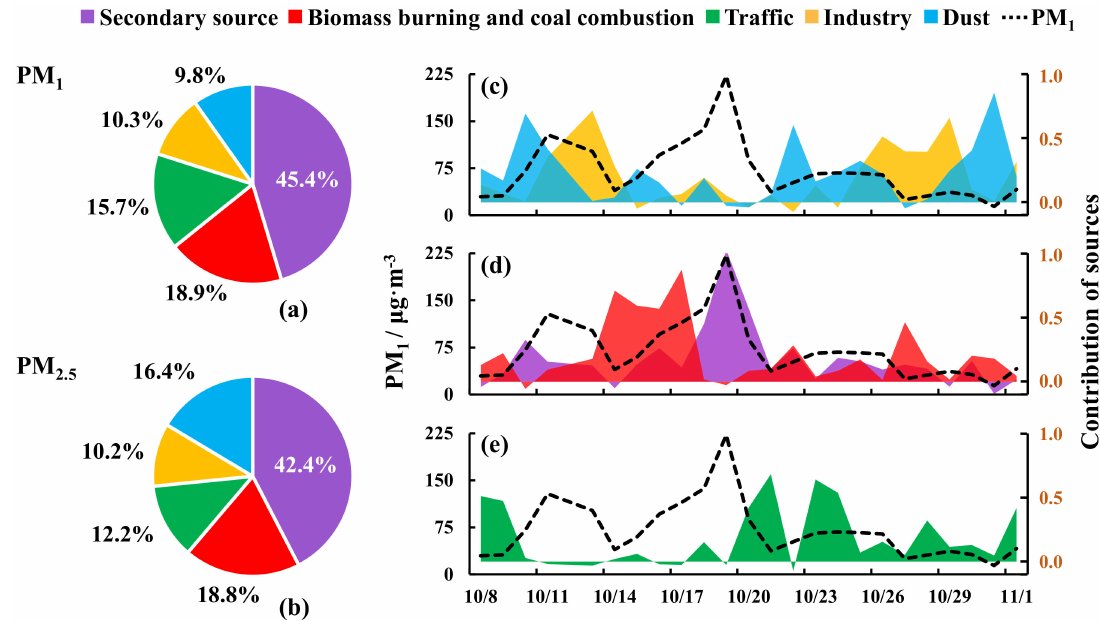
Figure 7. Positive matrix factorization (PMF) results of sources and their contributions to PM 1 ( a ) and PM 2.5 ( b ), and the time series during the study period ( c – e